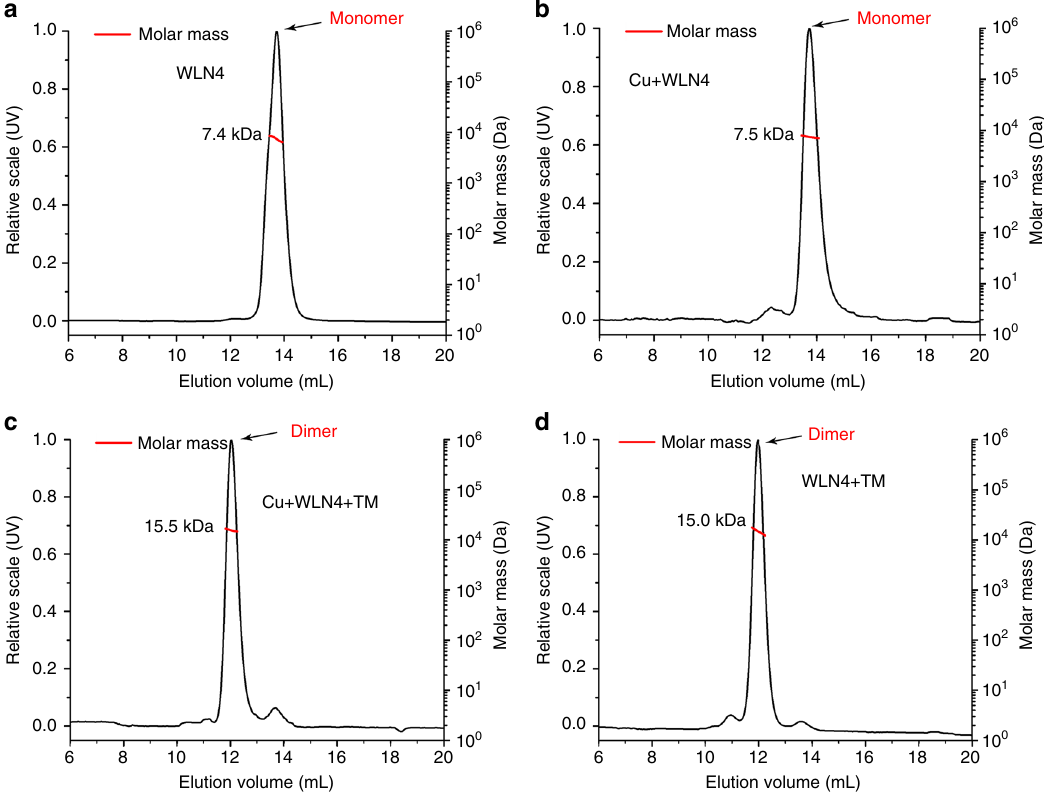
Fig. 2 SEC-MALS results of WLN4 protein. a apo-WLN4; b Cu-WLN4; c TM-WLN4 generated by incubation of TM with Cu-WLN4; d TM-WLN4 generated by incubation of TM with apo-WLN4. The Cu-WLN4 was produced by the reaction of apo-WLN4 with [Cu(CH 3 CN) 4 ]ClO 4 in 50 mM MES, 150 mM NaCl, pH 6.0. The calculated molecular weight and oligomeric state of each sample is labeled black and red, respectively